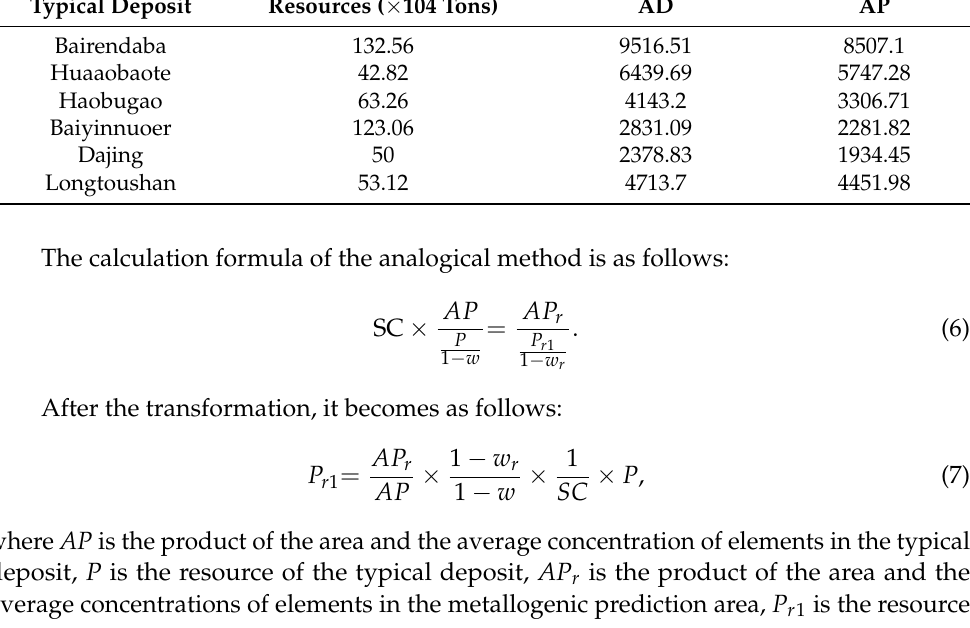
Table 1. The resources of Pb and Zn, anomaly dimension, areal productivity of the six typical deposits. Typical Deposit Resources ( × 104 Tons) AD